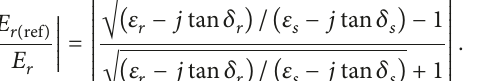
Figure 8: Field distribution in superstrate of Antenna #2 (top view).